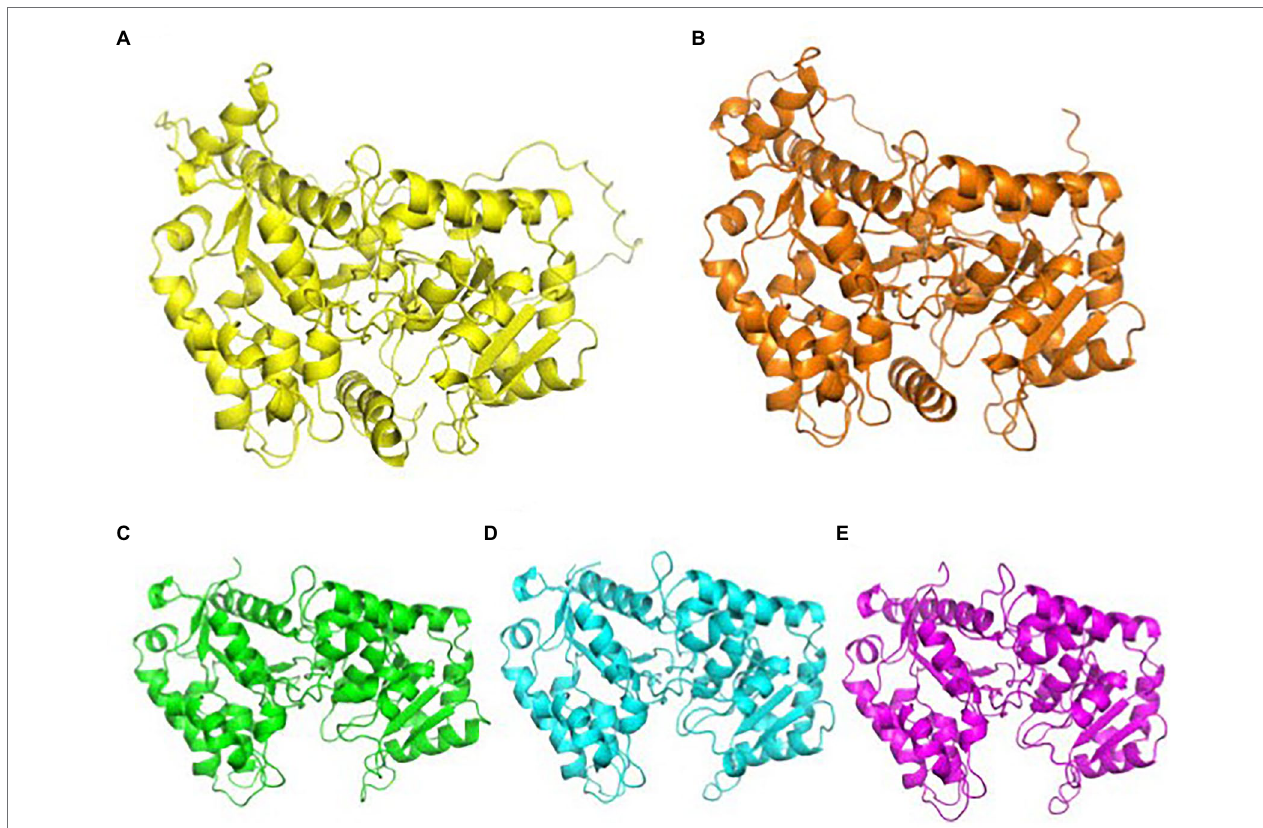
FIGURE 3 | AlphaFold predictions of CAZy family 47 GalTs and AraTs. GalTs are readily available at uniport.org, while AraTs were generated by AlphaFold for this review. (A) Structural prediction of AtMUR3, color: yellow. (B) Structural prediction of SlMUR3, color: orange. (C) Structural prediction of AtXLT2, color: green. (D) Structural prediction of SlXST1, color: cyan. (E) Structural prediction of SlXST2, color, magenta. The TMD and stem regions were removed for clarity. AlphaFold’s prediction of the TMD and stem regions of these proteins are highly inaccurate, as computation software still struggles with transmembrane proteins. Images were aligned and generated using